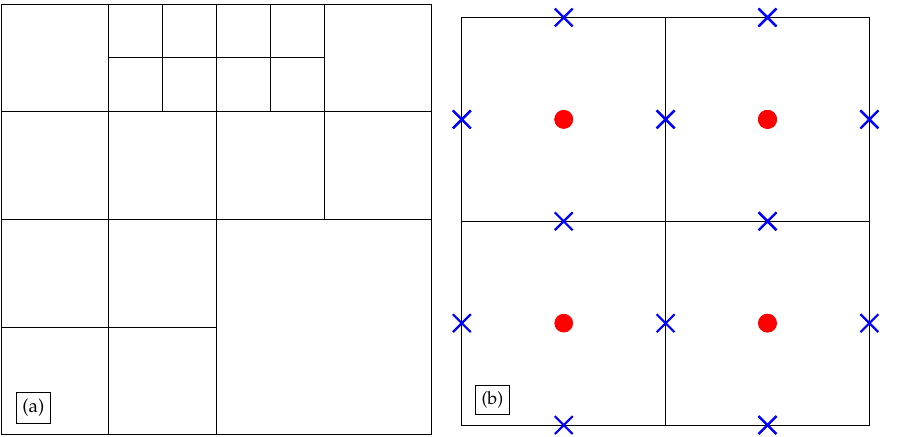
Figure 2. Structure of the adaptive computational mesh and variable definitions. ( a ) The quadtree discretization. ( b ) The staggered grid with some variables defined at the cell centers while others at the cell boundaries. Pressure p , velocity u , volume fraction ϕ of fluid 1, volume fraction χ of the solid, and density ρ are defined at the cell centers (red circles). Other variables, such as velocity u f , viscosity µ , acceleration a , and volume fraction of solids χ f are specified on the faces of cells (crosses) (note that some variables can be defined both at the centers and the